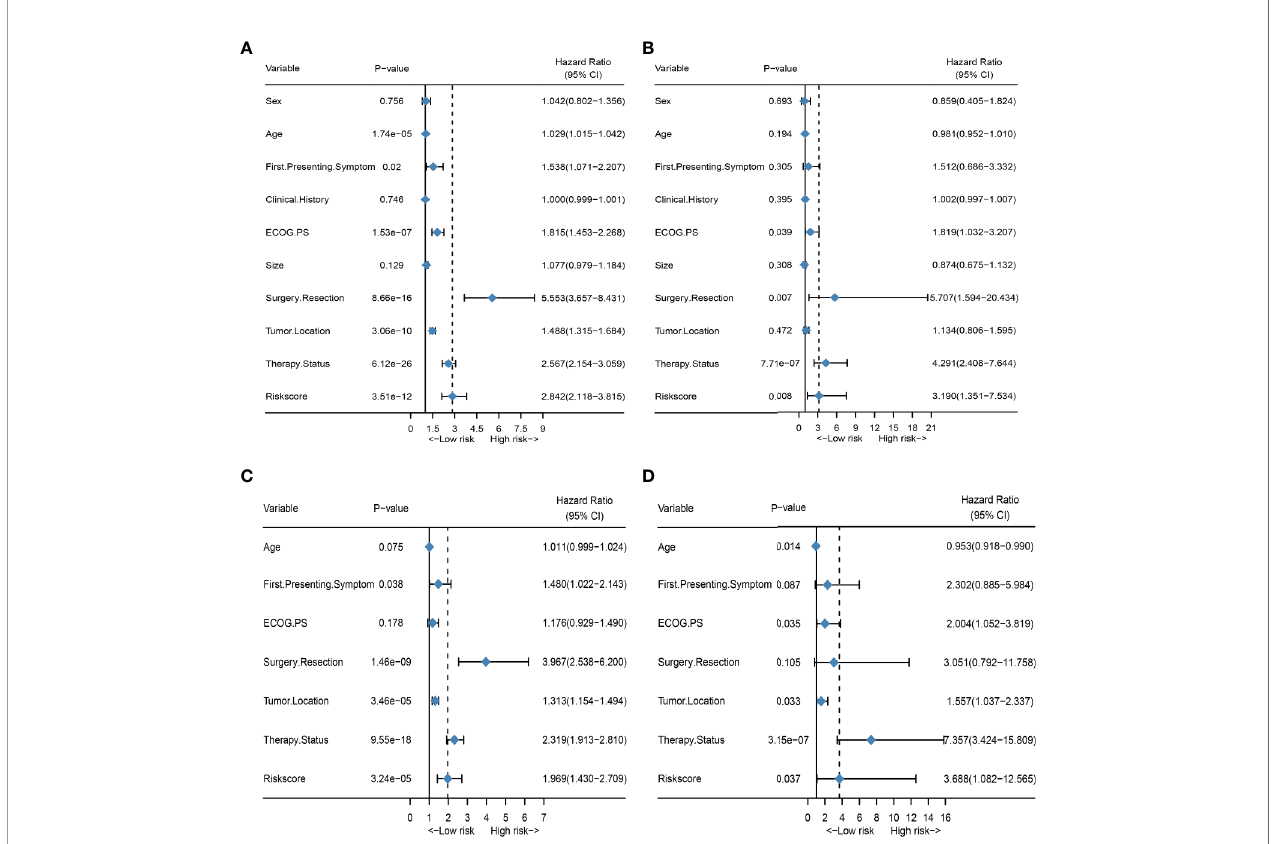
FIGURE 7 | Subgroup analysis of the IDH mutant and wild-type populations. (A) Forest plot of univariate Cox regression analysis of all clinical covariates in the IDH wild-type population; (B) Forest plot of univariate Cox regression analysis of all clinical covariates in the IDH mutant population; (C) Forest plot of multivariate Cox regression analysis of signi fi cant clinical covariates in the IDH wild-type population; (D) Forest plot of multivariate Cox regression analysis of signi fi cant clinical covariates in the IDH mutant